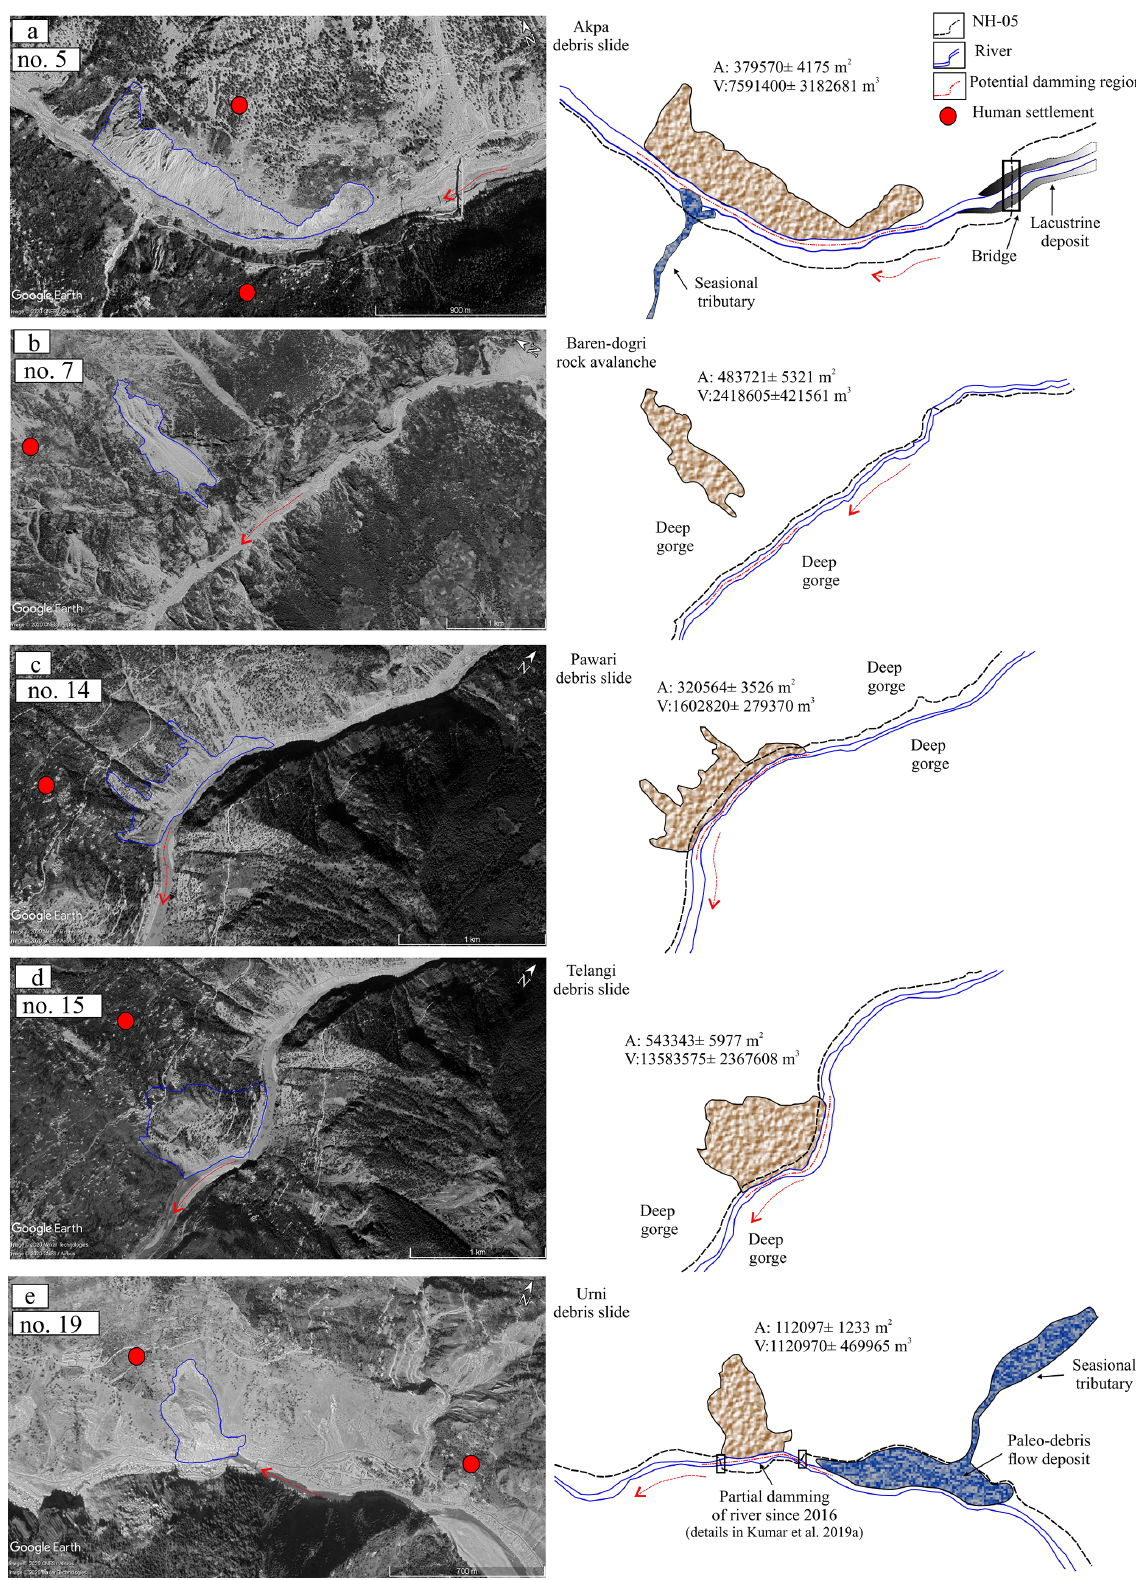
Figure 9. Potential landslide damming locations: (a) Akpa_III landslide, (b) Baren Dogri landslide, (c) Pawari landslide, (d) Telangi land- slide, and (e) Urni landslide. The dashed red arrow represents the direction of river flow. © Google Earth. Earth Surf. Dynam., 9, 351–377, 2021